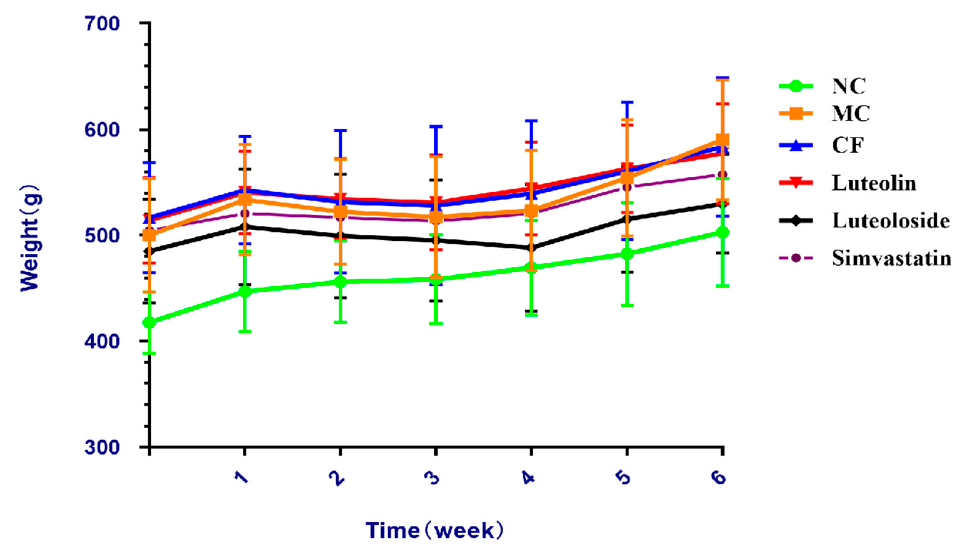
Figure 1. Body weight of different groups during intervention. Table 4. Body weight, liver weight, liver index, total fat, and body fat ratio in each group.